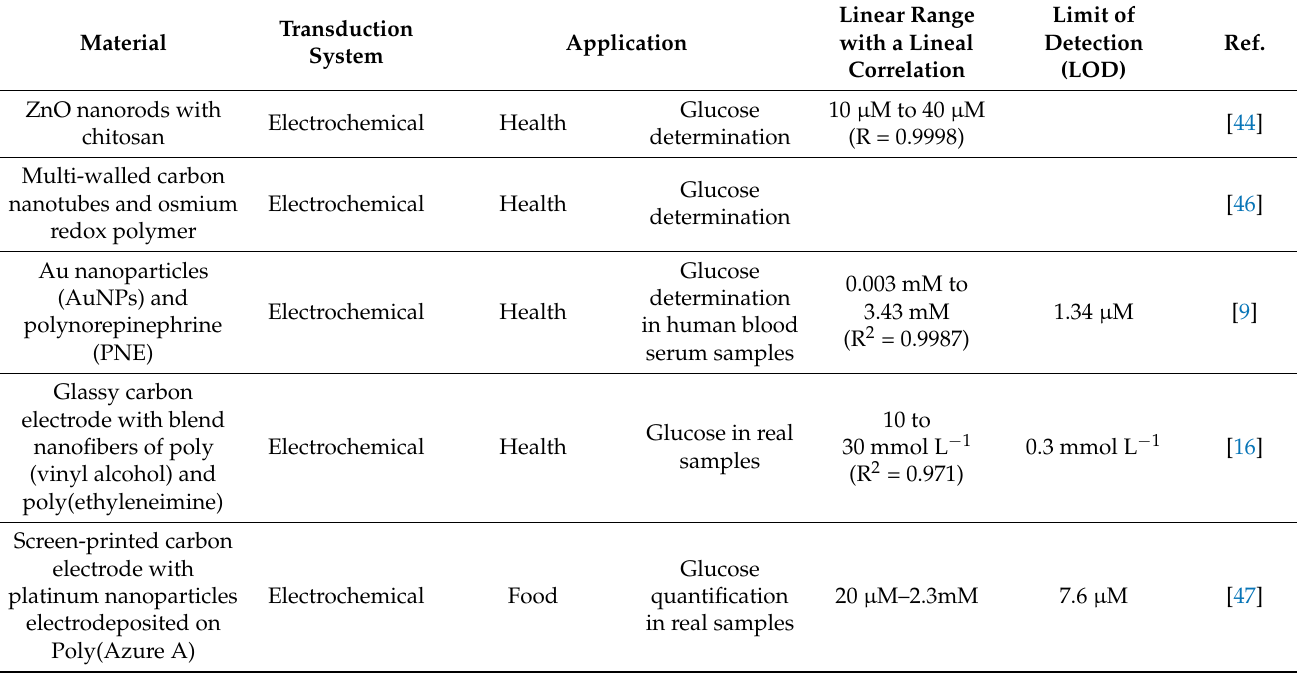
Table 2. Glucose oxidase